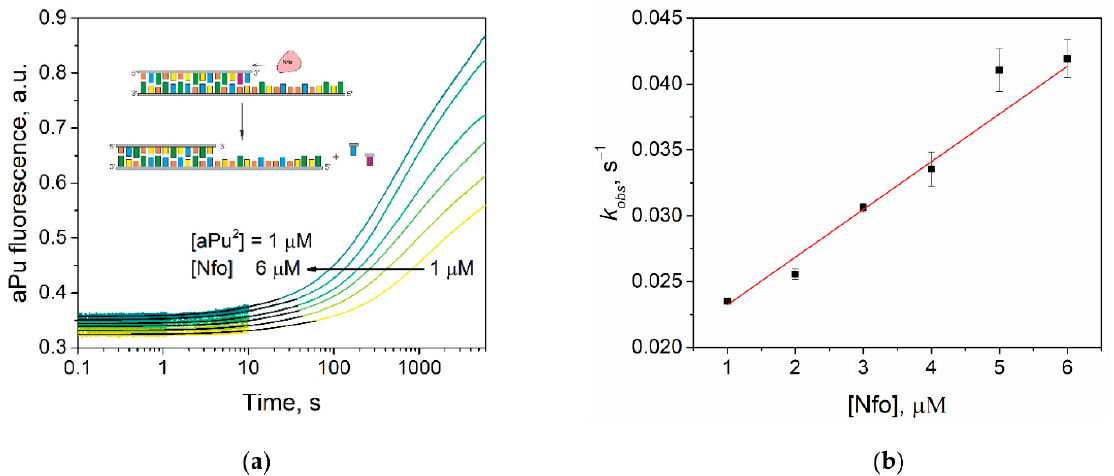
Figure 6. Changes in the fluorescence intensity of aPu during the interaction between Nfo and aPu 2 ( a ). The Nfo concentration dependence of the observed rate constant ( b ). [aPu 2 T ] = 1.0 µ M; Nfo concentration varied between 1.0 and 6.0 M. Table 2. Rate constants for interaction between Nfo and aPu 2 .